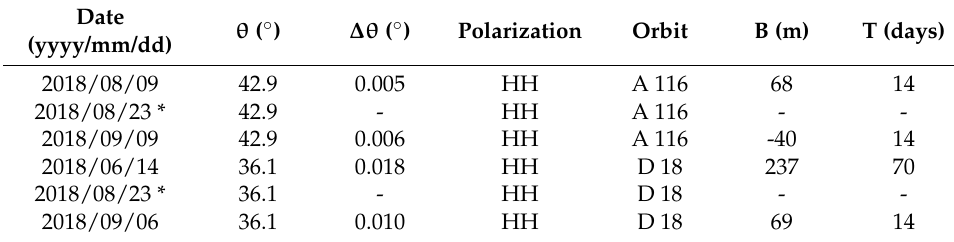
Figure 4. ( a ) Co-seismic interferogram of ascending orbit (116); ( b ) RGB change map of Hokkaido using normalized combination of pre-seismic and co-seismic coherence maps (116). Table 1. Detailed information of the PALSAR-2 data. θ , ∆ θ , B , and T are incidence angle, difference of incidence angle, normal baseline and temporal baseline, respectively. * in both the ascending and descending datasets indicates the master image.